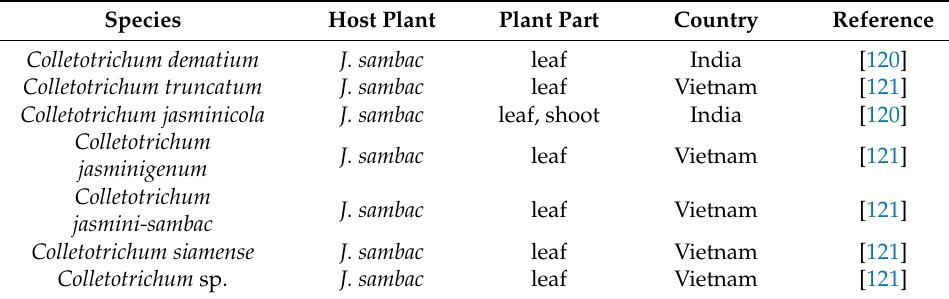
Table 10. Endophytic fungi isolated from Jasminum species.